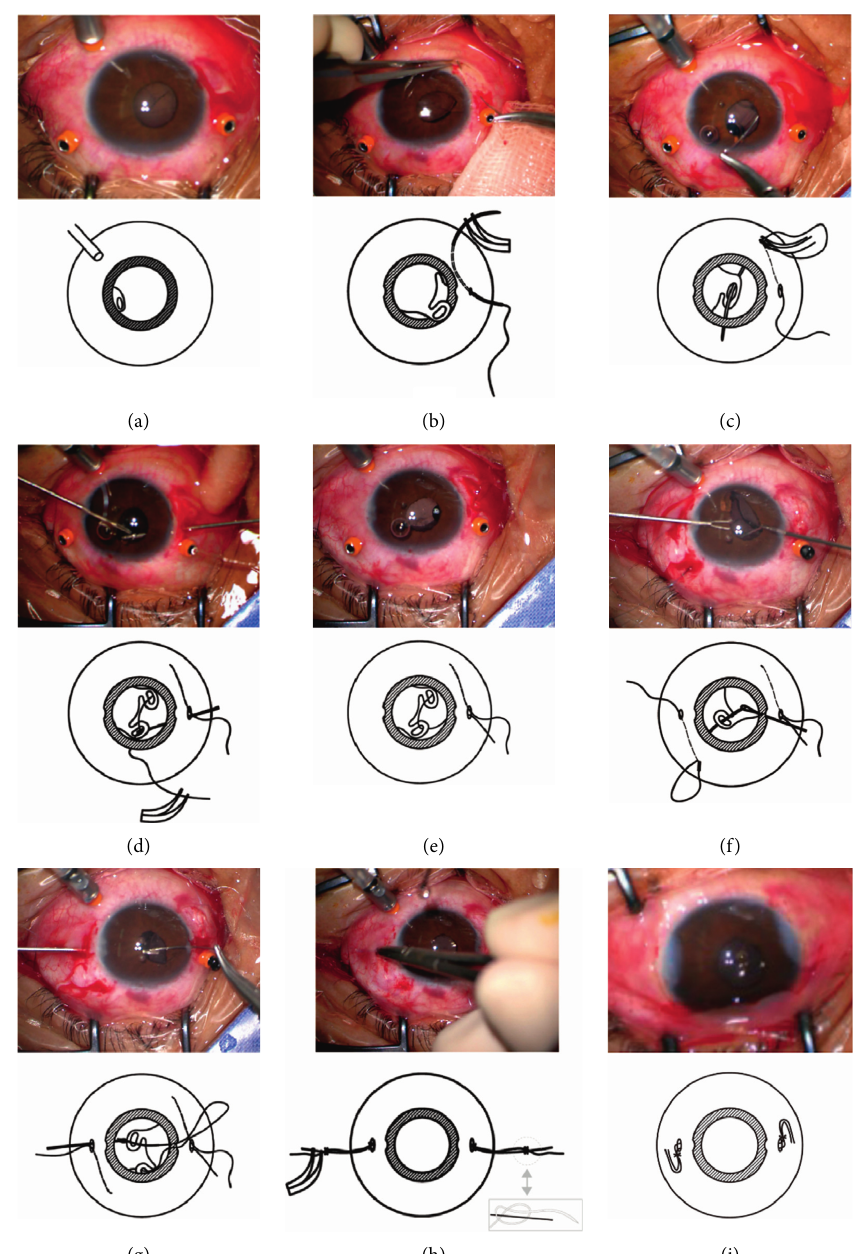
Figure 1: Surgical steps. (a) A dislocated intraocular lens (IOL). (b) After the IOL was brought to the posterior chamber, a CIF-4 needle with a double 10-0 polypropylene (Prolene ® ) suture was passed through the partial thickness of the sclera at the incision from the 9 o’clock to the 7 o’clock position. (c) The needle was inserted into the posterior chamber through the sclera at the 7 o’clock position and was passed through the nasal inferior eyelet and then externalized through the limbus at the 1 o’clock position. (d) The needle was then removed, and the suture was reintroduced into the anterior chamber and passed through the nasal superior eyelet using vitreous forceps. (e) Using these vitreous forceps, the suture was then externalized through the scleral incision at 9 o’clock. (f) On the temporal side, after passing through the sclera from 3 o’clock to 1 o’clock, the needle was introduced into the posterior chamber, passed through the temporal superior eyelet, and externalized through the nasal limbus incision with the help of vitreous forceps. (g) Through the same incision, the needle was reintroduced into the anterior chamber, passed through the temporal inferior eyelet, and externalized through the scleral incision at 3 o’clock using vitreous forceps. (h) The two ends of the suture, on both sides, were tied and care was taken to centralize the IOL. Then, the suture with a CIF-4 needle was tied to the other suture tail (or tails lacking a needle) using a sliding knot (shown in the small diagram). (i) The sutures were passed through the partial thickness of the sclera, twice, using a technique similar to the Z-suture technique described by Szurman et